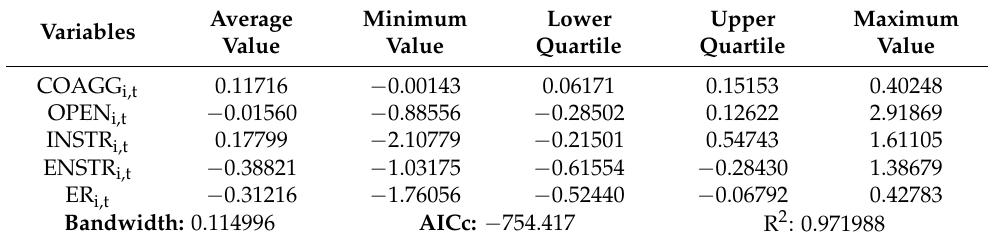
Table 5. Results of GTWR